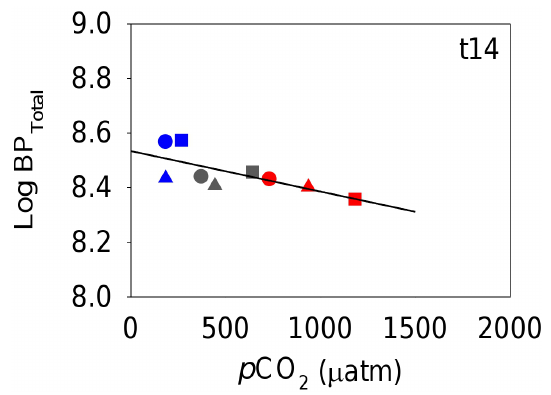
Fig. 6. Relationship between p CO 2 value and log BP Total at t 14. Liner regression line at t 14: LogBP Total =− 0.00015 × p CO 2 + 8 . 53 (r 2 = 0 . 51, p < 0 . 05, n = 9).